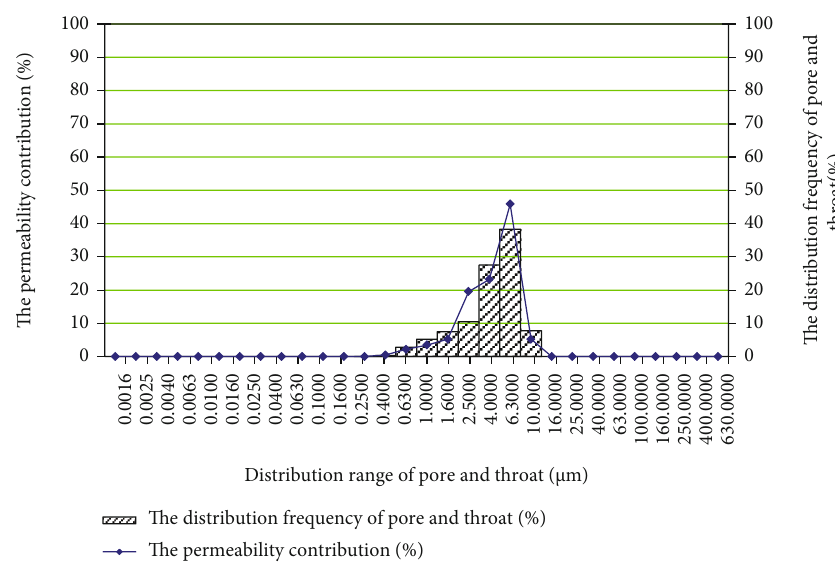
Figure 9: Core pore radius distribution results under the original state of core 21-2.